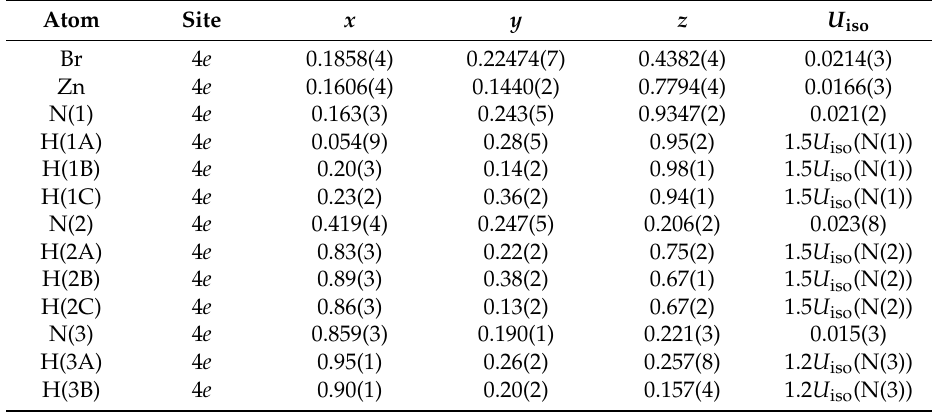
along [010] (Figure 3). According to the composition, only 1/8 of the tetrahedral voids exclusively formed by two ammonia molecules and two amide ions are occupied by Zn. As discussed above for the chloride, the distances to the terminal ammonia ligands with 204(3) pm and 211(3) pm are significantly longer than those to the bridging amide ligands with 198.4(8) pm and 200.2(8) pm. Angles around Zn with 104°–123.8° deviate little from to the ideal tetrahedral angle. Table 6 collects selected interatomic distances and angles. Vertex-sharing via amide ligands leads to 2/221 ( ) ( ) +   Zn NH NH zigzag chains running along [010]. According to the Liebau nomenclature,   3 2 ∞ these chains are classified as unbranched zweier single-chains with molar ratio of n (Zn): n (N) = 1:3 [12]. Once again, these chains may be viewed as sections from the three-dimensional crystal structure of binary zinc amide, formally broken up by the addition of HBr. 2/221 ( ) ( ) +   Zn NH NH zigzag chains each via eight Bromide ions interconnect three   3 2 ∞ H-bonds (see Figure 3). Table 7 gives relevant donor–acceptor distances and angles. For both title compounds, there are no indications for a rotational disorder of the ammonia ligands, prohibited by an involvement in hydrogen bonding networks.